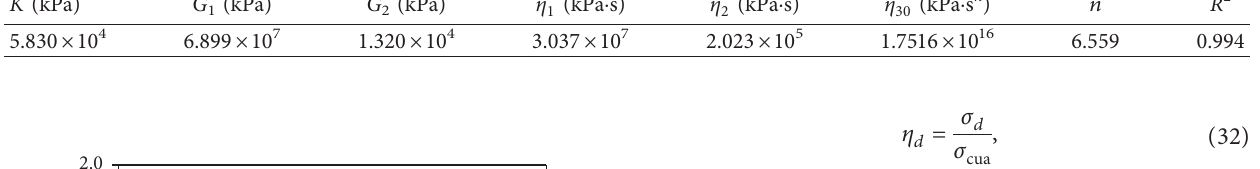
Table 2: NVPFM parameters of the water-rich soft rock under 200kPa confining pressure when η